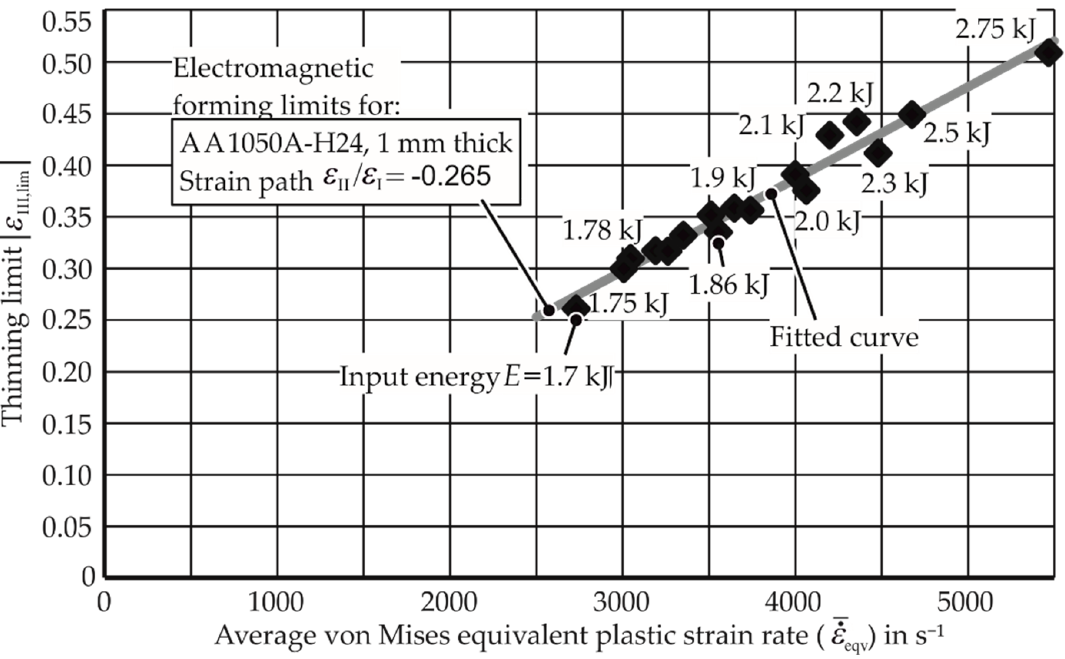
Figure 15. Electromagnetic forming limits of AA-1050a-H24 under uniaxial tension. Thinning limit is the amount of thinning at the onset of necking.